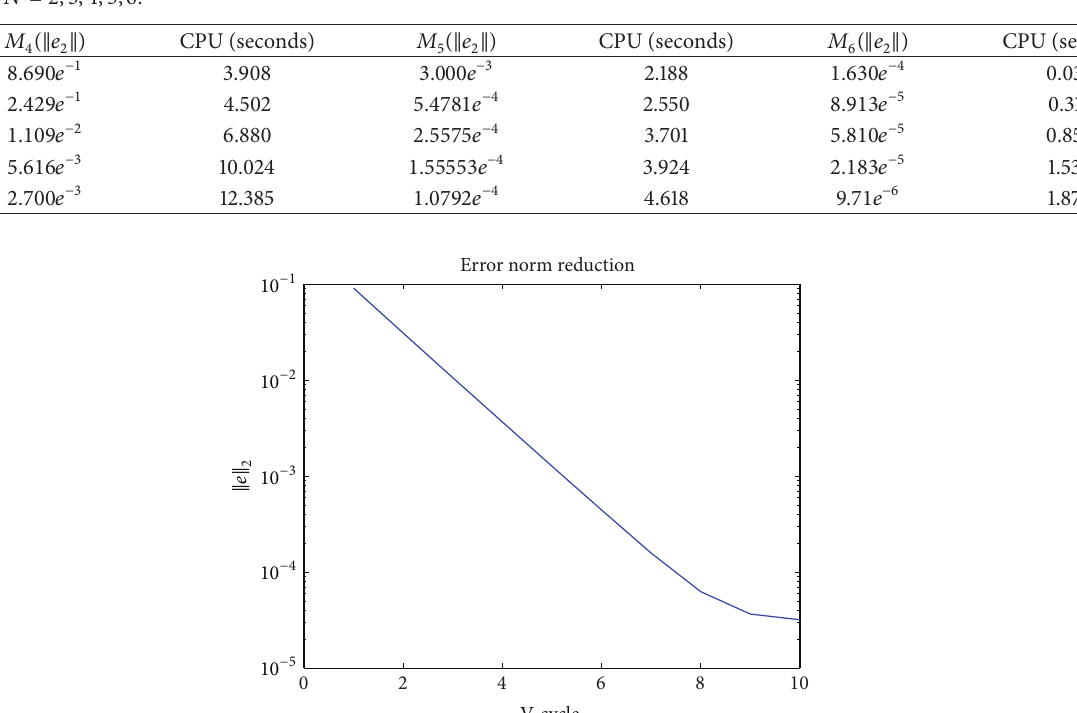
Table 4: Comparison of maximum absolute errors and CPU (seconds) for a Multigrid method with different schemes, for Example 4, ‖𝑒 2 ‖ , ℓ = 10 , and 𝑁 = 2, 3, 4, 5, 6 .